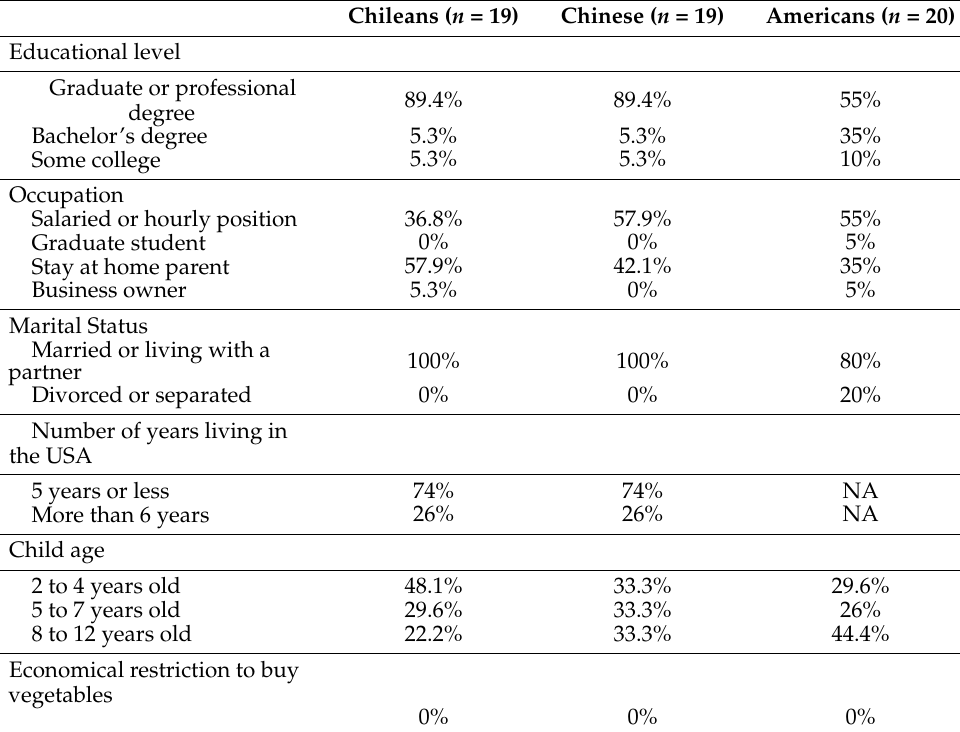
Table 2. Participants’ characteristics